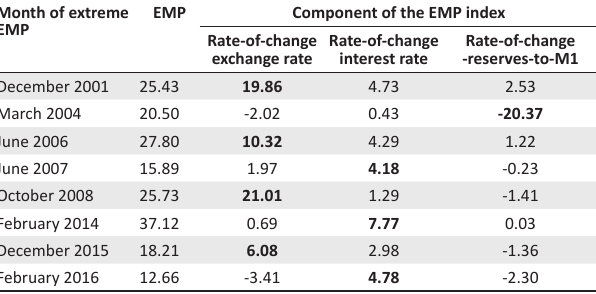
Month of extreme EMP Component of the EMP EMP